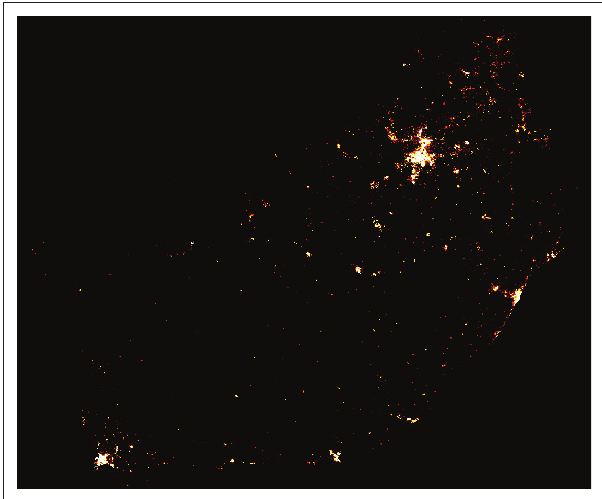
FIGURE 3: Defence Meteorological Satellite Program–Operational Linescan System night-time lights South Africa, 2013.